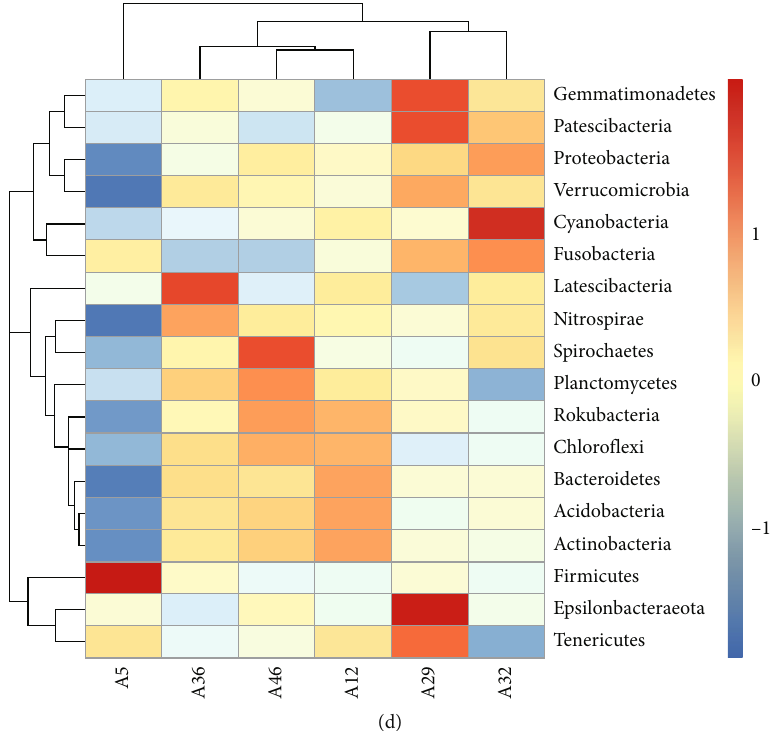
Figure 1: OTU distribution and taxonomy in liver microbiota (phyla). (a) OTU number of samples. (b) Venn diagram. (c) Species distribution (phyla). (d) Abundance heat map